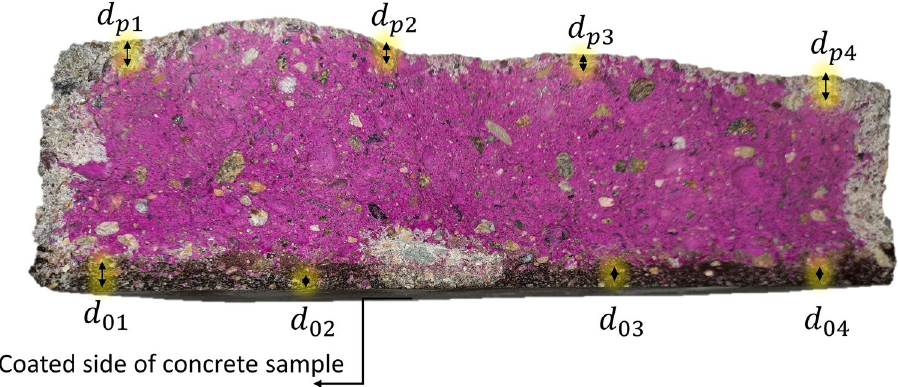
Figure 5. Carbonation measurement on both sides of concrete samples.